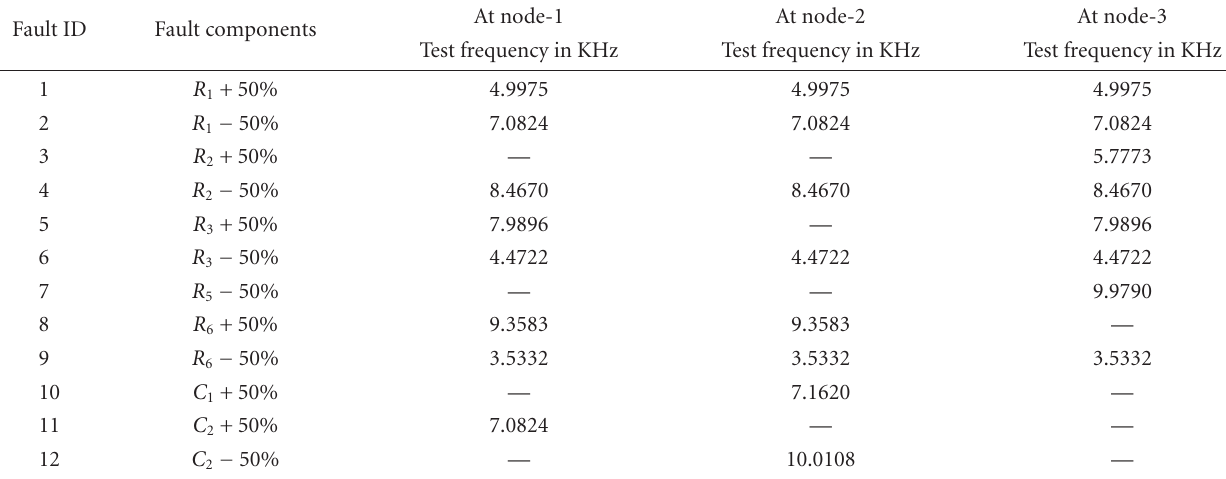
Table 6: Test frequencies of the single faults (dashes mean no access to